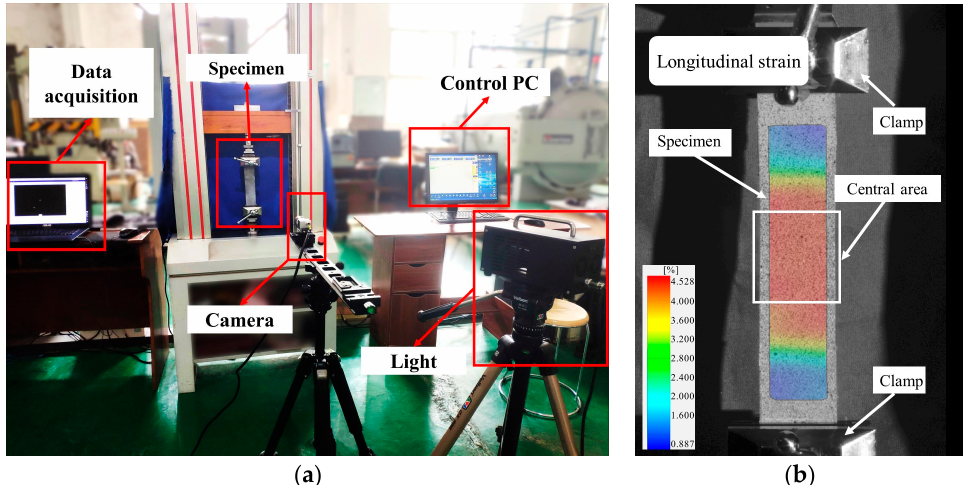
Figure 7. Uniaxial tensile test of the fabric membrane: ( a ) schematic diagram of samples ( b ) longitudinal strain contours of the samples.